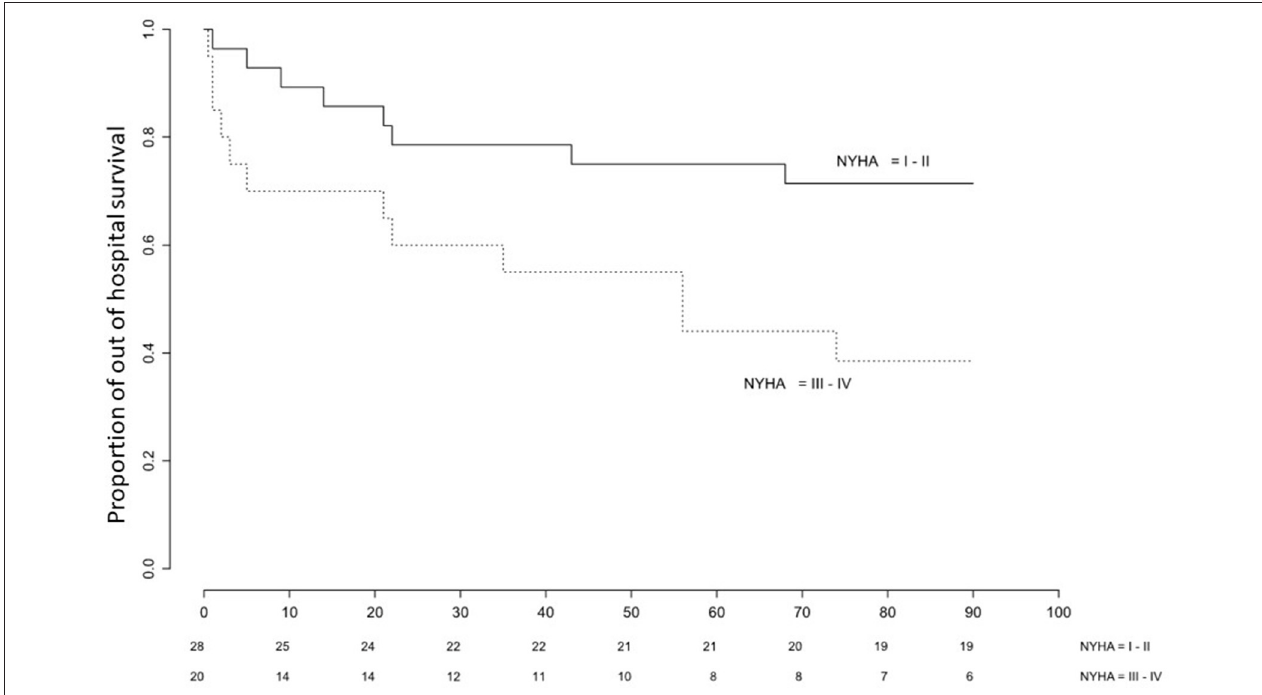
FIGURE 1 | Kaplan-Meier plot of time to event (readmission or death) in COPD patients surviving index ICU admission for acute hypercapnic respiratory failure stratified on NYHA class (III-IV vs. I-II).